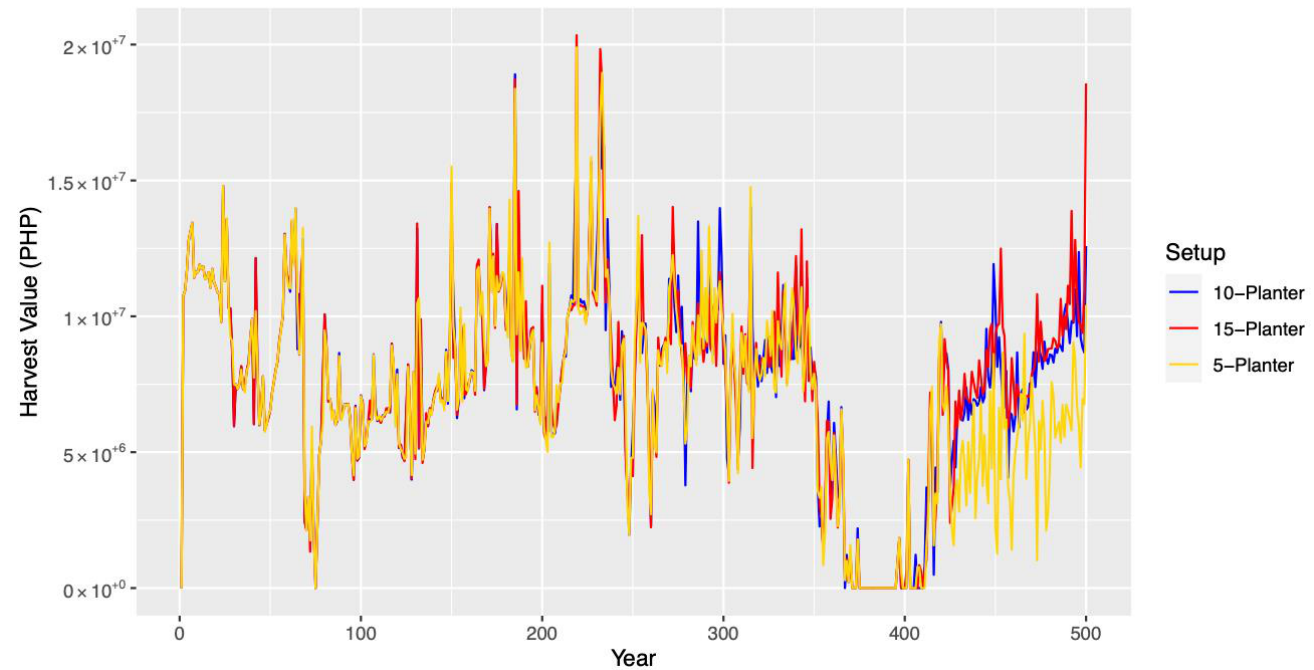
Figure 6. Result of the 500-year simulation on three setups: 5-planter, 10-planter, and 15-planter.